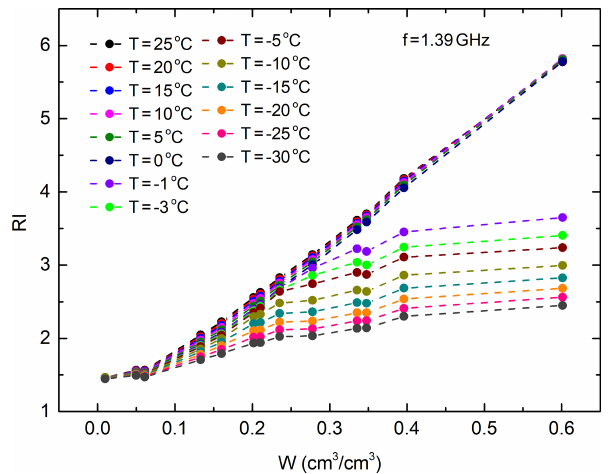
Figure 6. Refractive index (RI) for sample no. 6 (TM) as a function of soil sample moisture ( W ) for various temperatures at a frequency of f = 1.39GHz.